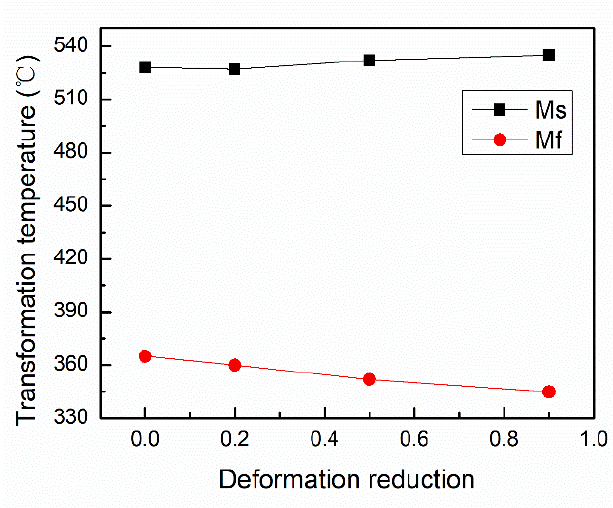
Figure 13. Phase transformation temperatures for the low-carbon ferritic stainless steel samples with the different deformation reductions.